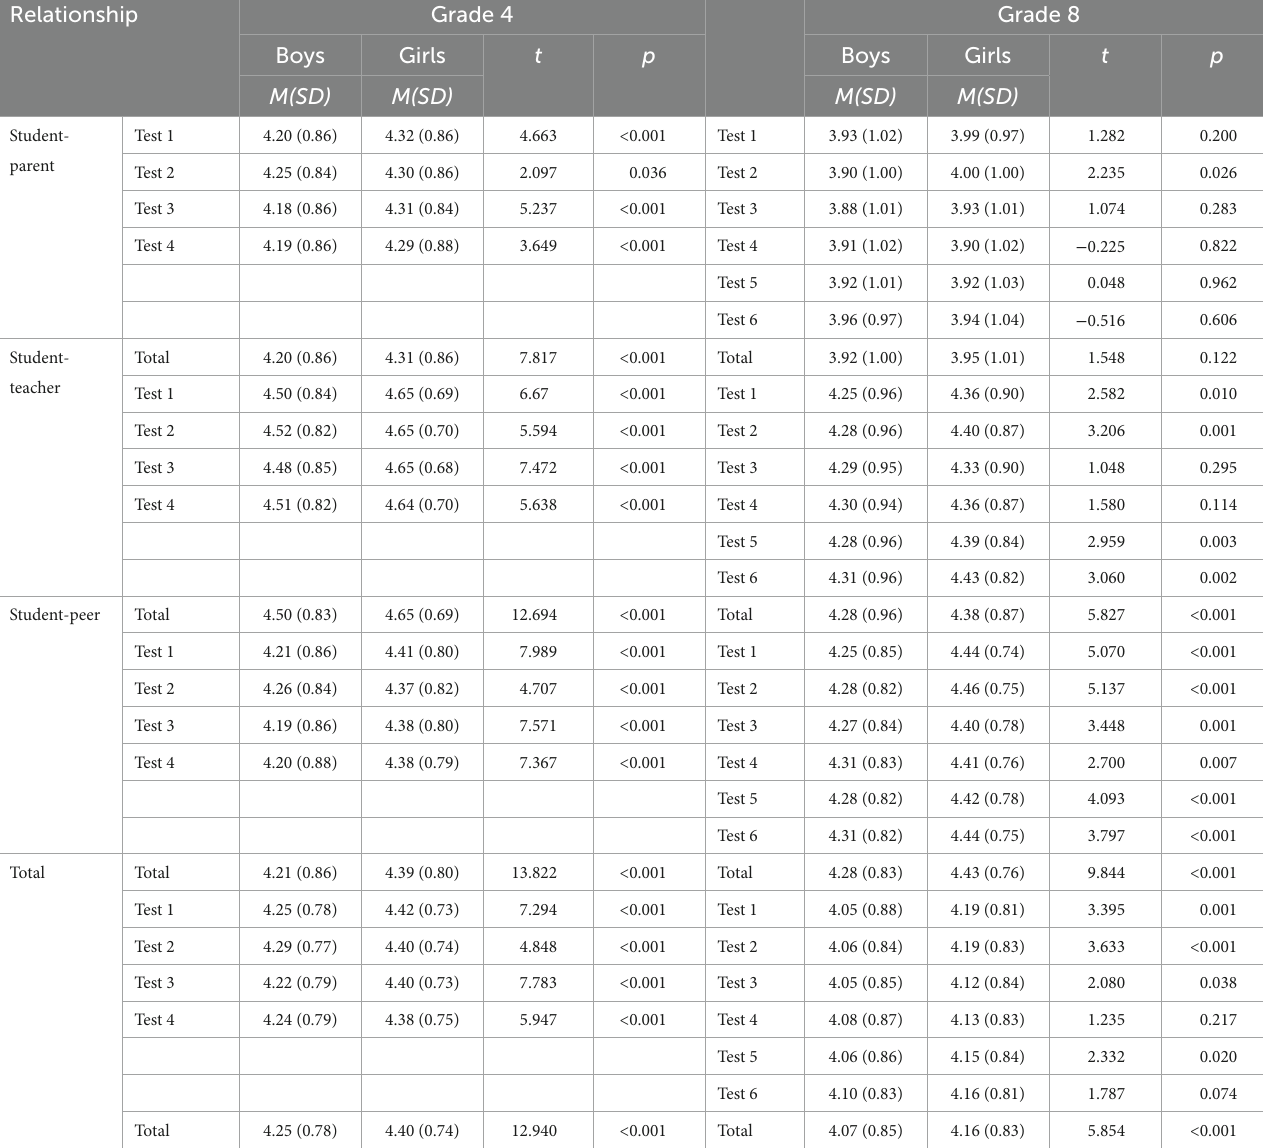
TABLE 7 Mean (SD) values and independent sample T test results for gender in personal relationships.